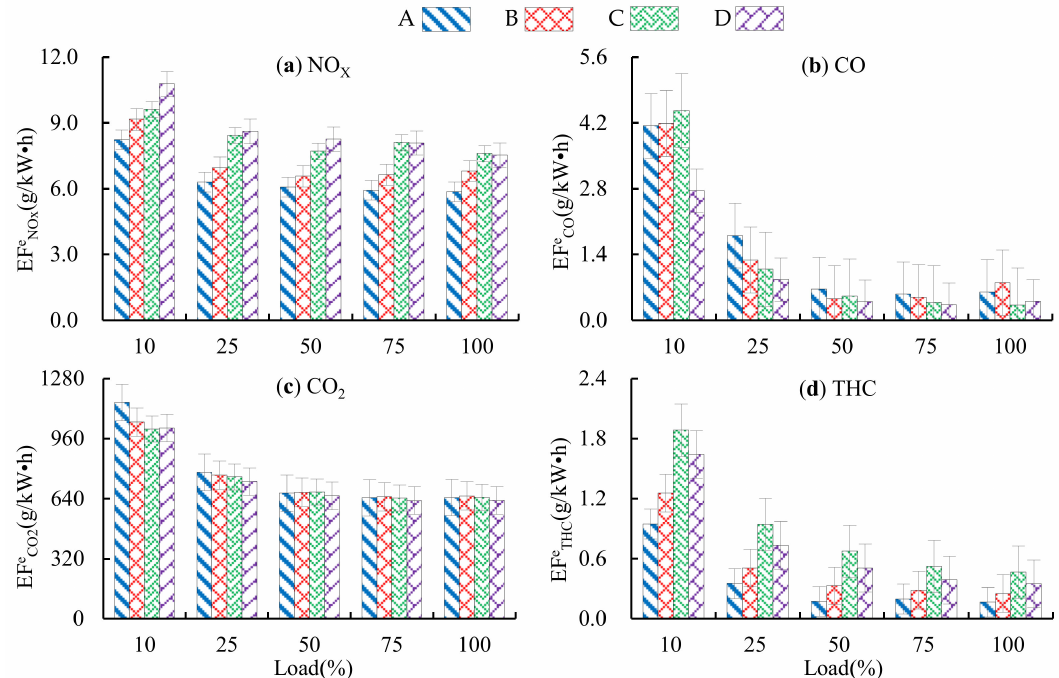
Figure 5. Relationship of energy-based emission factors against engine load for AE. Energy-based emission factors at five load points for the auxiliary engine. ( a ) NO X energy-based emission factors, ( b ) CO energy-based emission factors, ( c ) CO 2 energy-based emission factors, and ( d ) THC energy-based emission factors. The diesel engine works at a constant